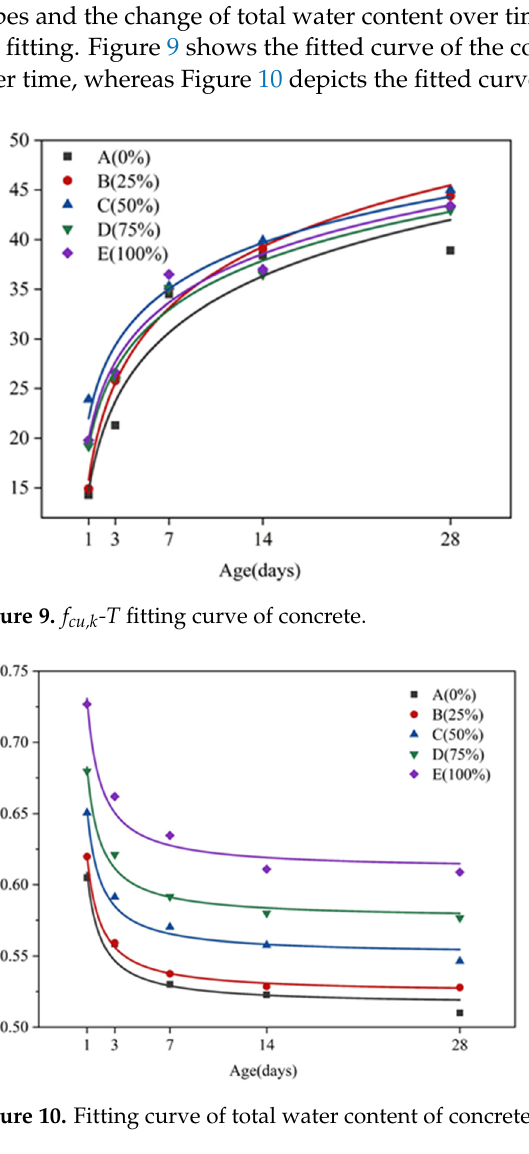
Figure 8. Different forms of water content and total water content in concrete of different ages: ( a ) A (Replacement amount: 0%); ( b ) B (Replacement amount: 25%); ( c ) C (Replacement amount: 50%); ( d ) D (Replacement amount: 75%); ( e ) E (Re- placement amount: 100%).